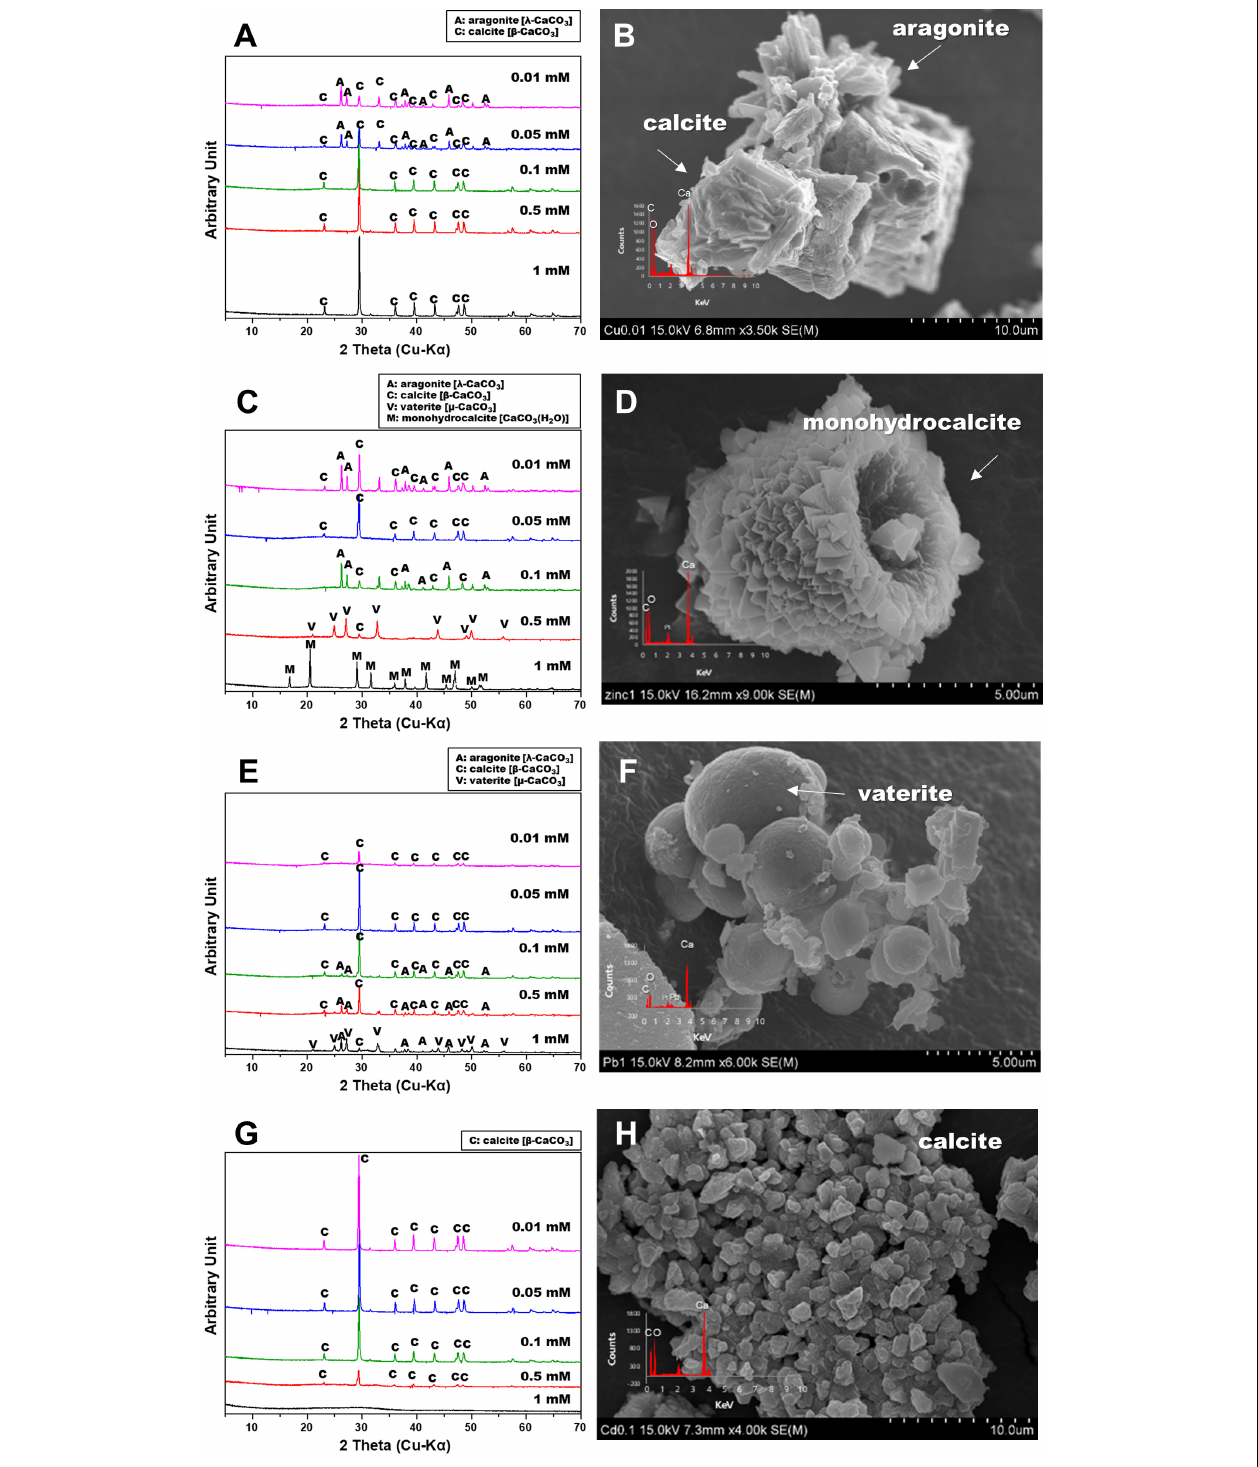
FIGURE 3 | X-ray diffraction spectra and scanning electron microscopy images of calcium carbonate precipitated from various metals: Cu (A,B) ; Zn (C,D) , Pb (E,F) , and Cd (G,H) .